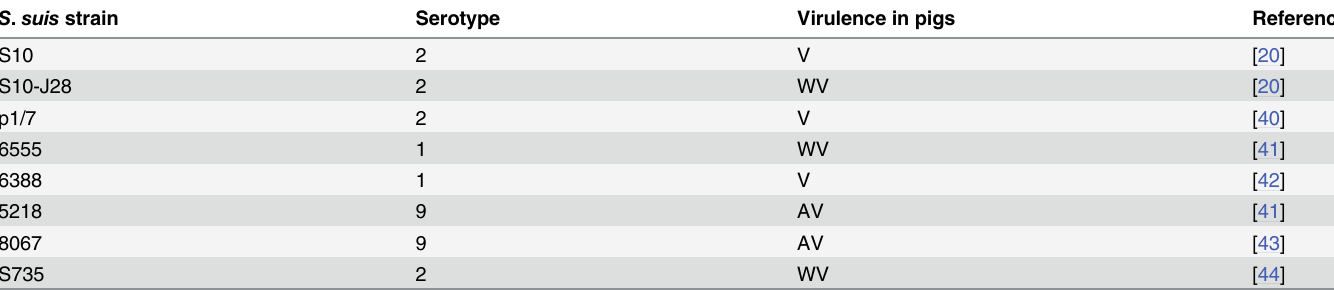
Table 1. S . suis strains used in this study and their virulence. V, virulent; WV, weakly virulent; AV, avirulent. S . suis strain